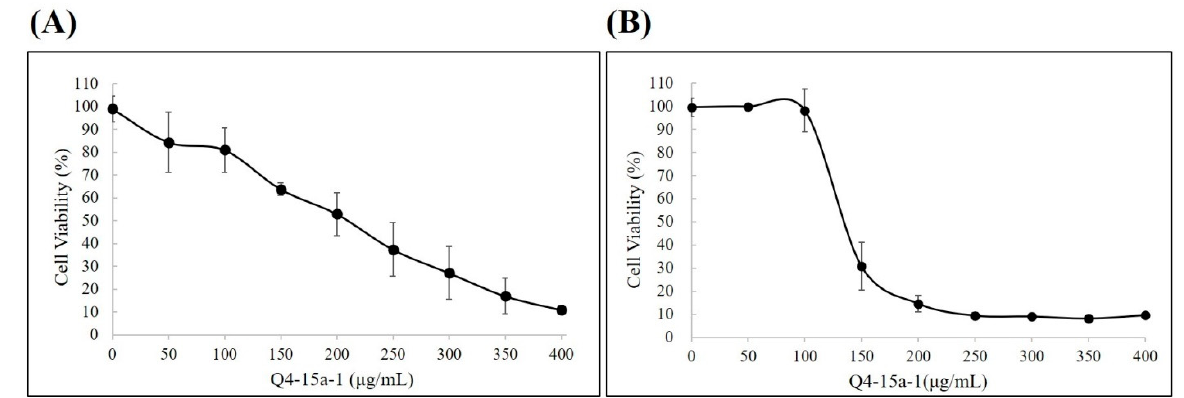
Figure 6. Cell viability of ( A ) intestinal porcine epithelial cell line-1 (IPEC-1) and ( B ) intestinal porcine epithelial cell line-J2 (IPEC-J2) upon exposure to different concentrations of AMP Q4-15a-1.